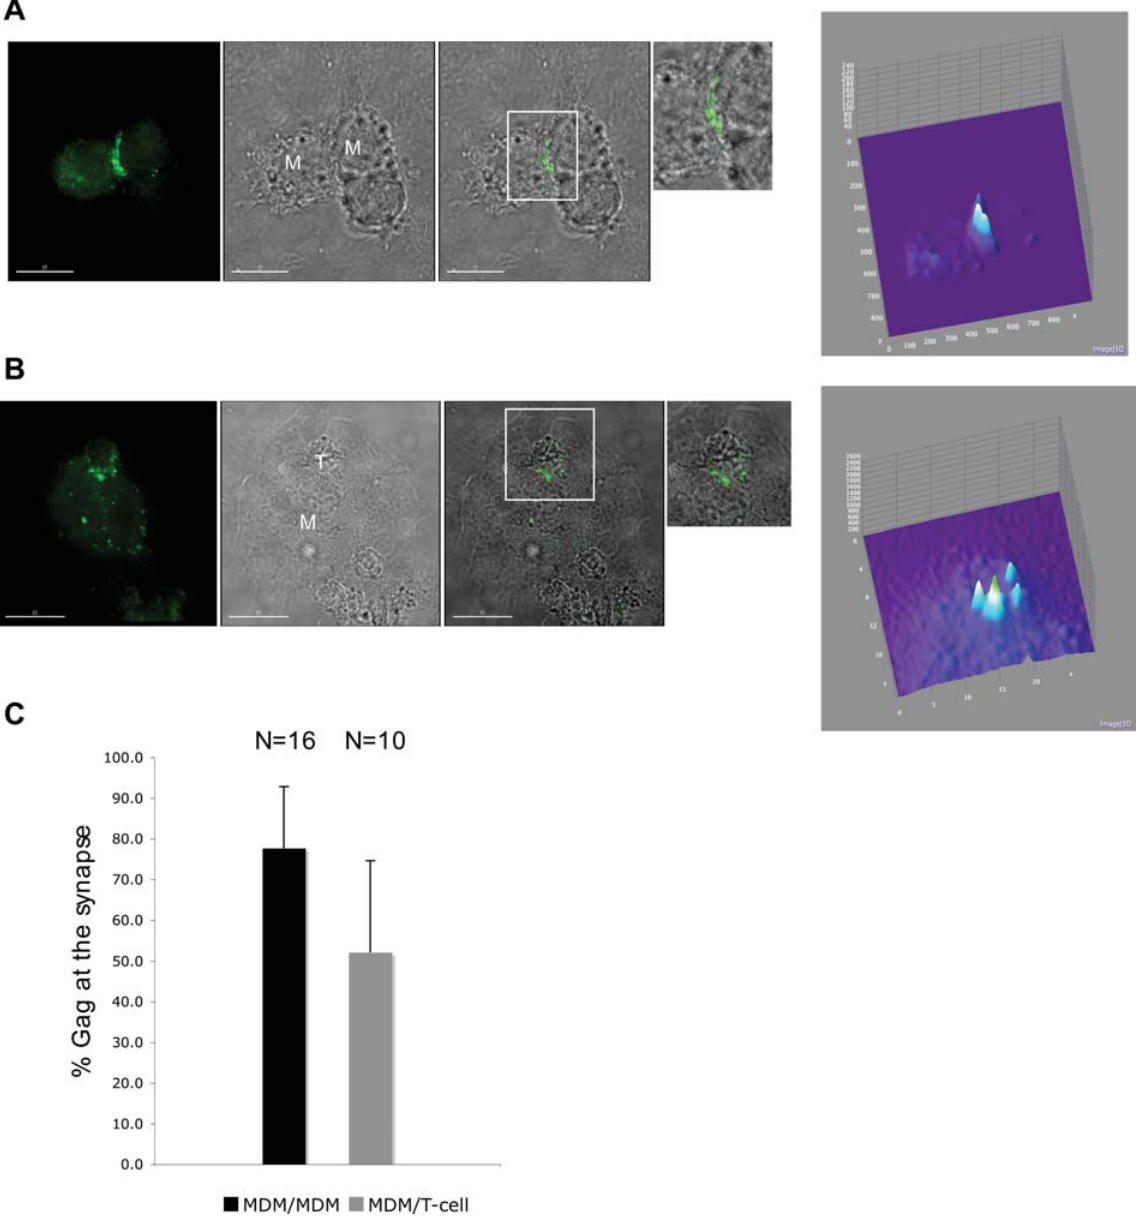
Scale bars=15 m m. (B) MDMs were infected as in (A), and Jurkat T cells were added after FlAsH labeling. Far-right panels in (A) and (B) provide quantification of the Gag signals, determined as indicated in the Fig. 5 legend. Scale bars=15 m m. (C) Quantification of Gag concentration at the synapse, determined as described in the Fig. 6C legend. For more information on how the Gag quantification was performed, see Fig. S3B.